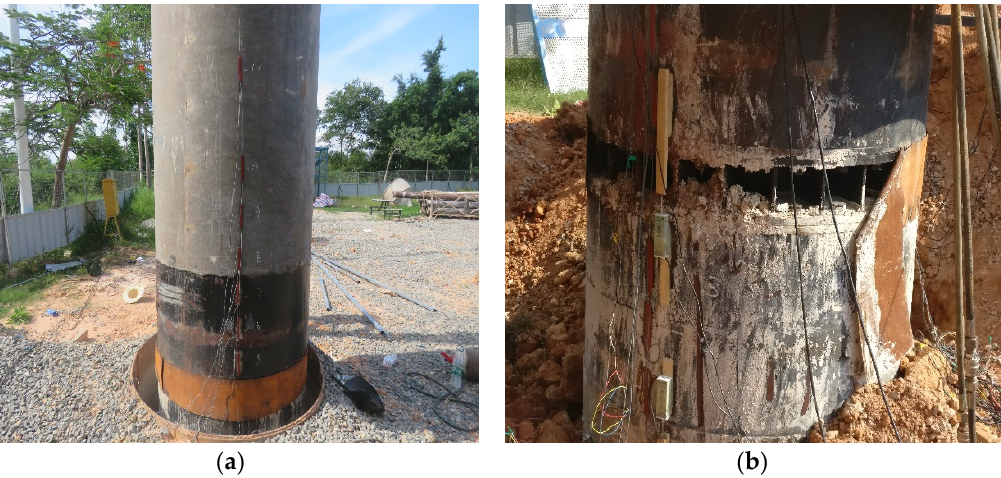
Figure 12. Field reliability test of pile–column connection: ( a ) arrangement of strain measuring points and ( b ) arrangement of displacement measuring points at flange